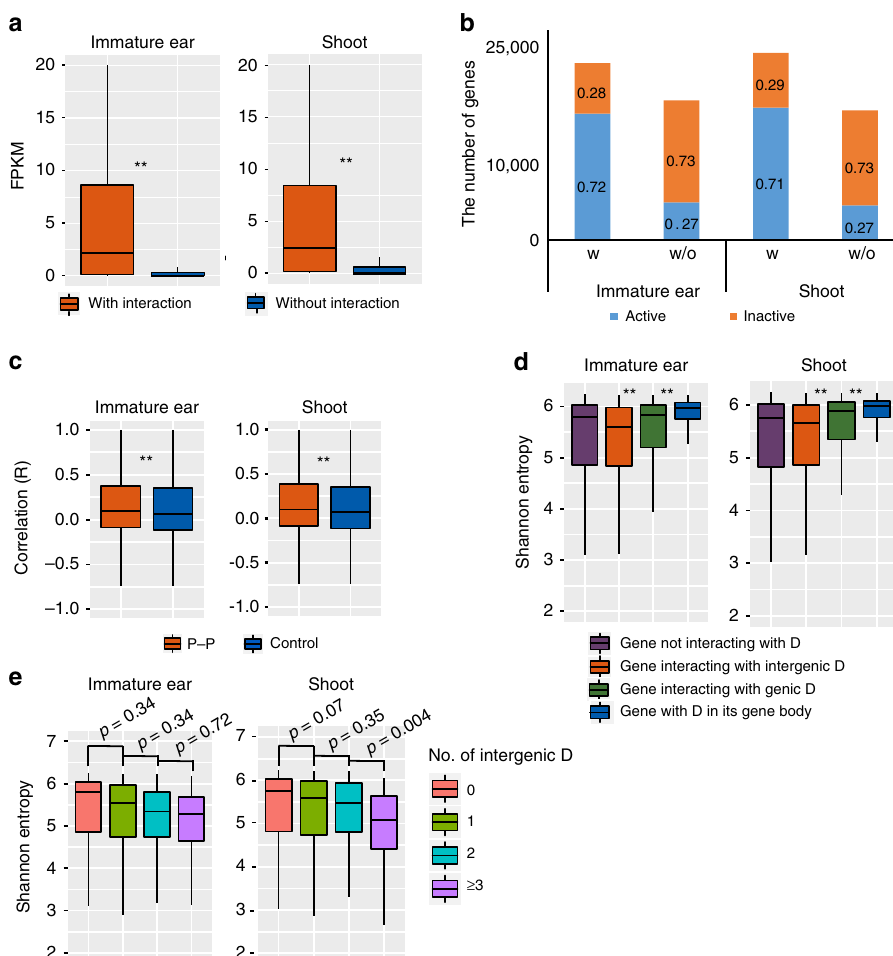
Fig. 5 The association of chromatin interaction and gene expression. a The comparison of fragments per kilobase of transcript per million (FPKM) for genes interacting or not interacting with chromatin interactions (** p <2.2e − 16, two-sided t test). b Transcriptional status of genes with (w) or without (w/o) interactions. The bar plot shows the number of corresponding genes with the proportion labeled on the bar. ‘ Inactive ’ indicates gene with FPKM <1, ‘ Active ’ indicates gene with FPKM ≥ 1. ‘ w ’ represents genes with chromatin interactions; ‘ w/o ’ represents genes without chromatin interactions. c The comparison of expression correlation between gene pairs with proximal – proximal (P – P) interaction and controls in immature ear and shoot (immature ear: ** p = 2.521e − 08, shoot: ** p = 3.6e − 14, two-sided t test). d The comparison of Shannon entropy of gene interacting with genic D or intergenic